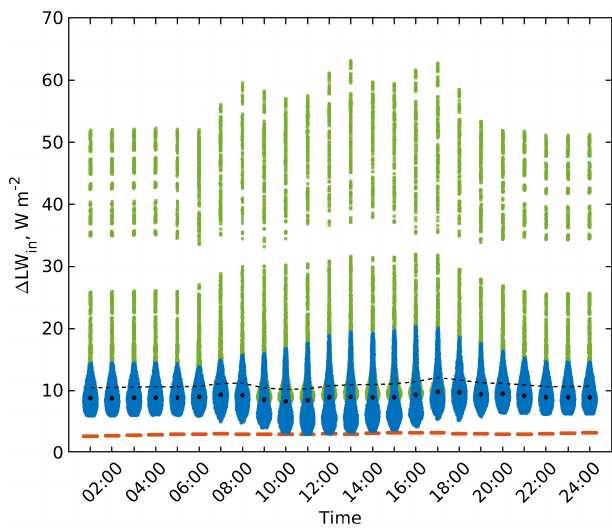
Figure 11. Changes in the received LW irradiance within the fo- cus domain of the simple urban configuration when considering tree thermal emissions (RTM_05) compared to the RTM_04. Vi- olin, mean, and median colours are used in the same way as those in Fig.